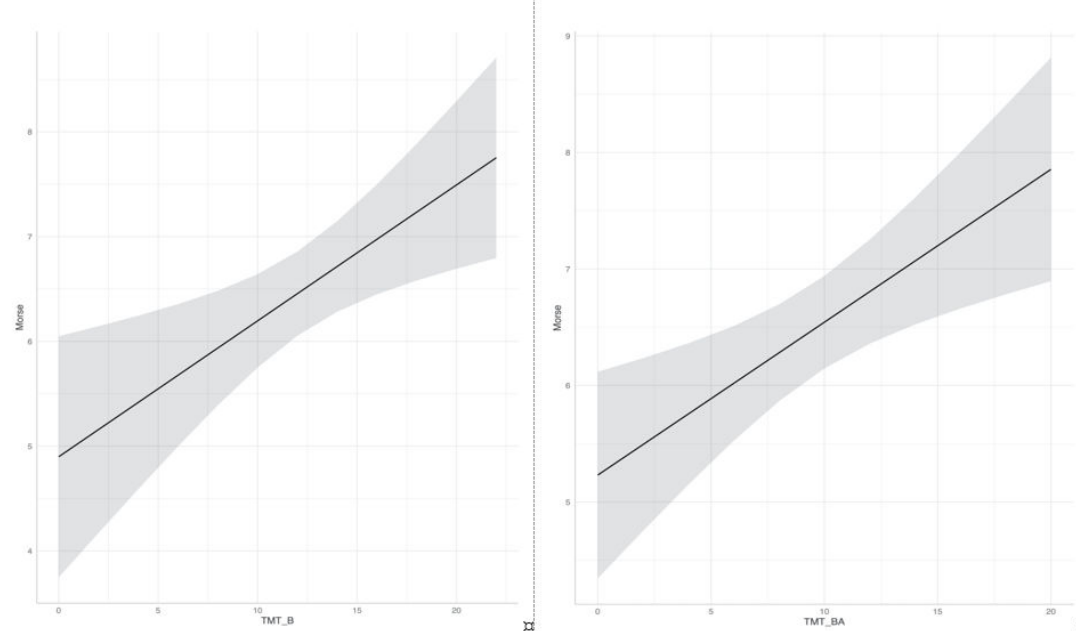
Figure 2. Causal association of TMT-B and TMT-BA square rooted scores on fall risk square rooted scores. TMT: Trail Making